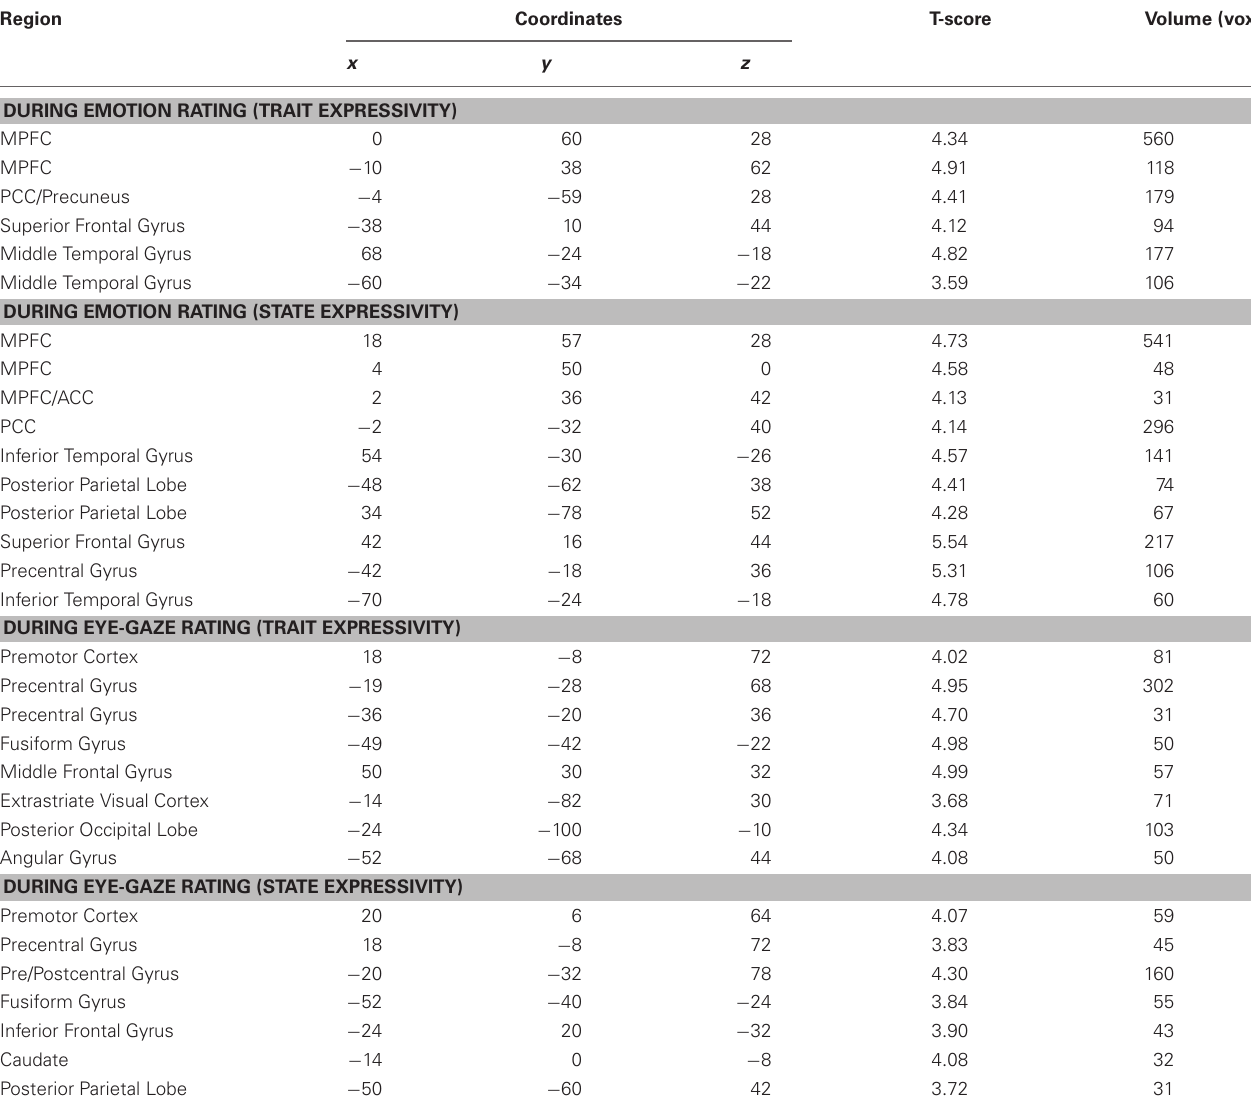
Table 2 | Modulation of brain activity by target expressivity. Region Coordinates T-score